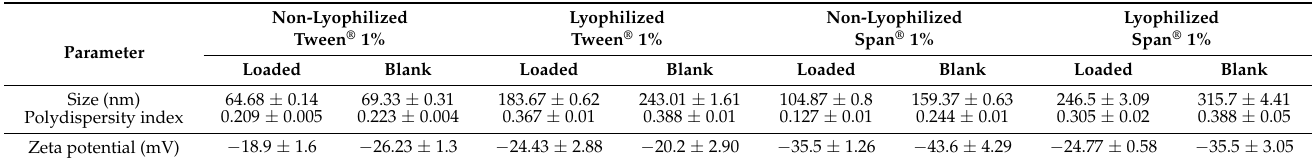
Table 2. Size distribution and polydispersity of blank and CysA-loaded transferosomes.